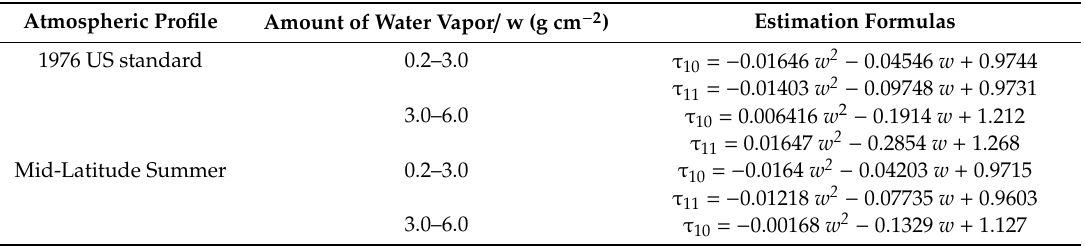
Table 2. Estimation formulas for atmospheric transmittance calculation—Landsat 8 TIRS